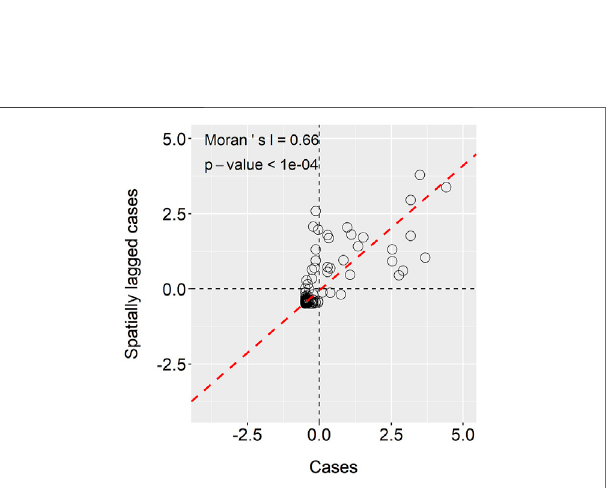
FIGURE 6 | Global Moran ’ s I index of county-level COVID-19 con fi rmed cases in Guangdong.